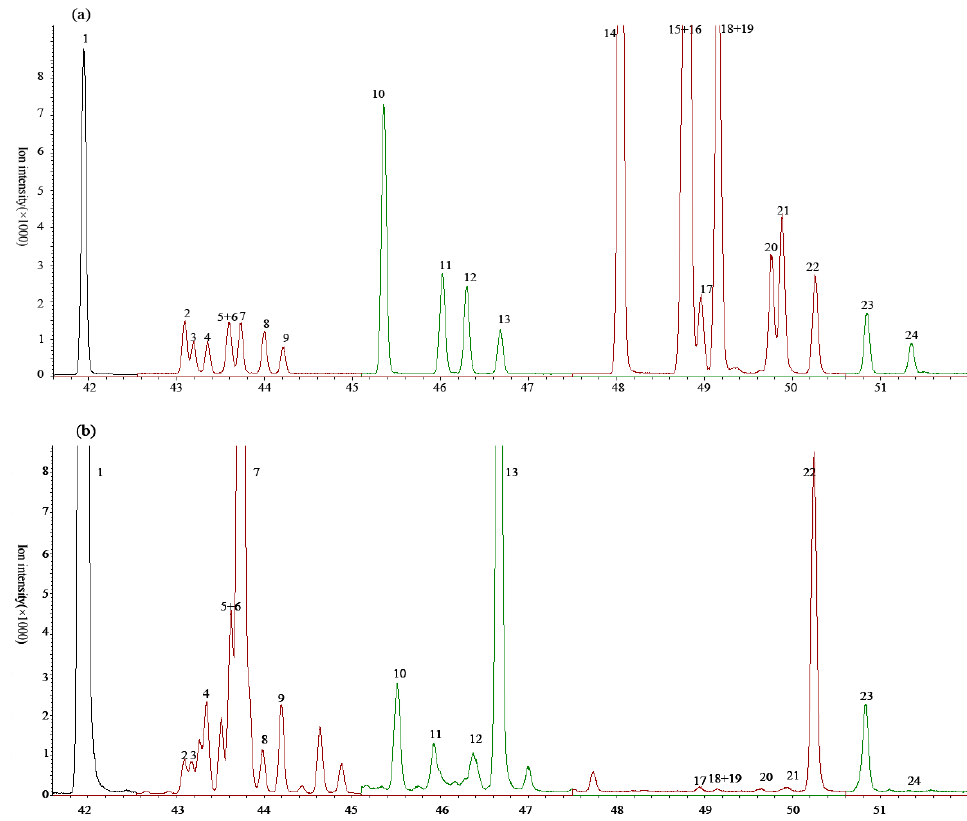
Figure 1. Total ion chromatogram of 24 eighteen-carbon fatty acids methyl esters (C18 FAMEs) by GC-MS. ( a ) Standards in n -hexane; ( b ) in raw milk. The number of FAMEs in Table 1 are labeled on the peaks.